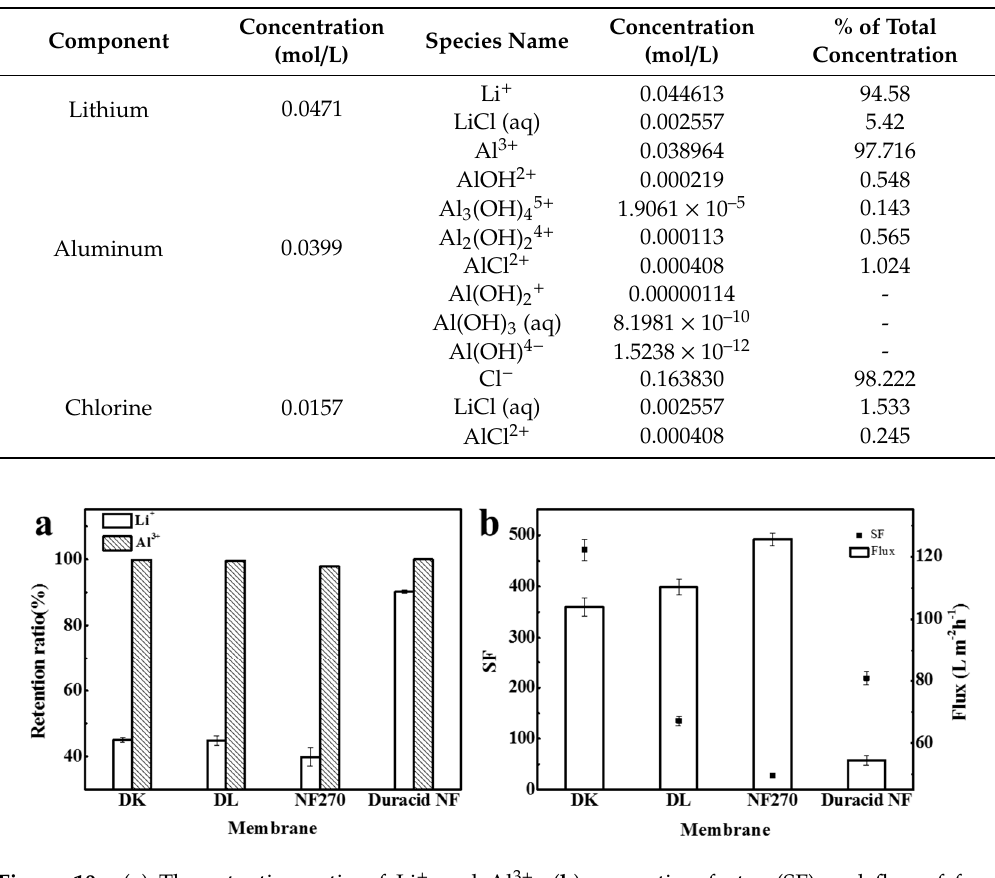
Figure 10. ( a ) The retention ratio of Li + and Al 3 + ; ( b ) separation factor (SF) and flux of four NF membranes. Table 9. Retention ratio of Li + and Al 3 + , separation factor (SF), flux, and permeate pH of four NF